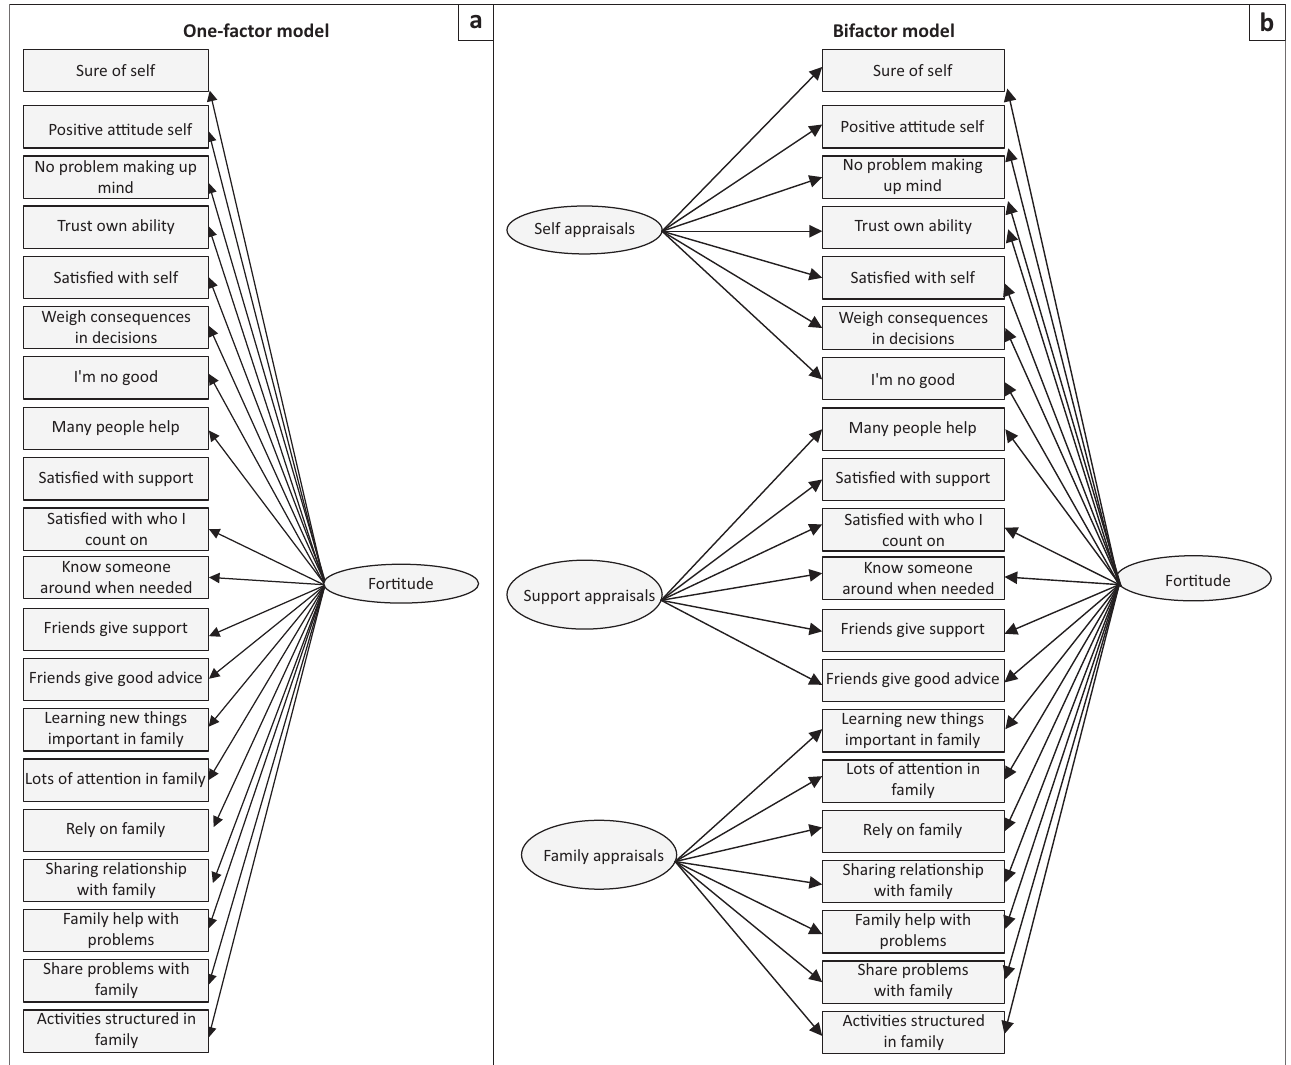
FIGURE 1: One-factor and bifactor models of the factor structure of Fortitude Questionnaire. Rectangles are the observed measurements (items), and ellipses are latent